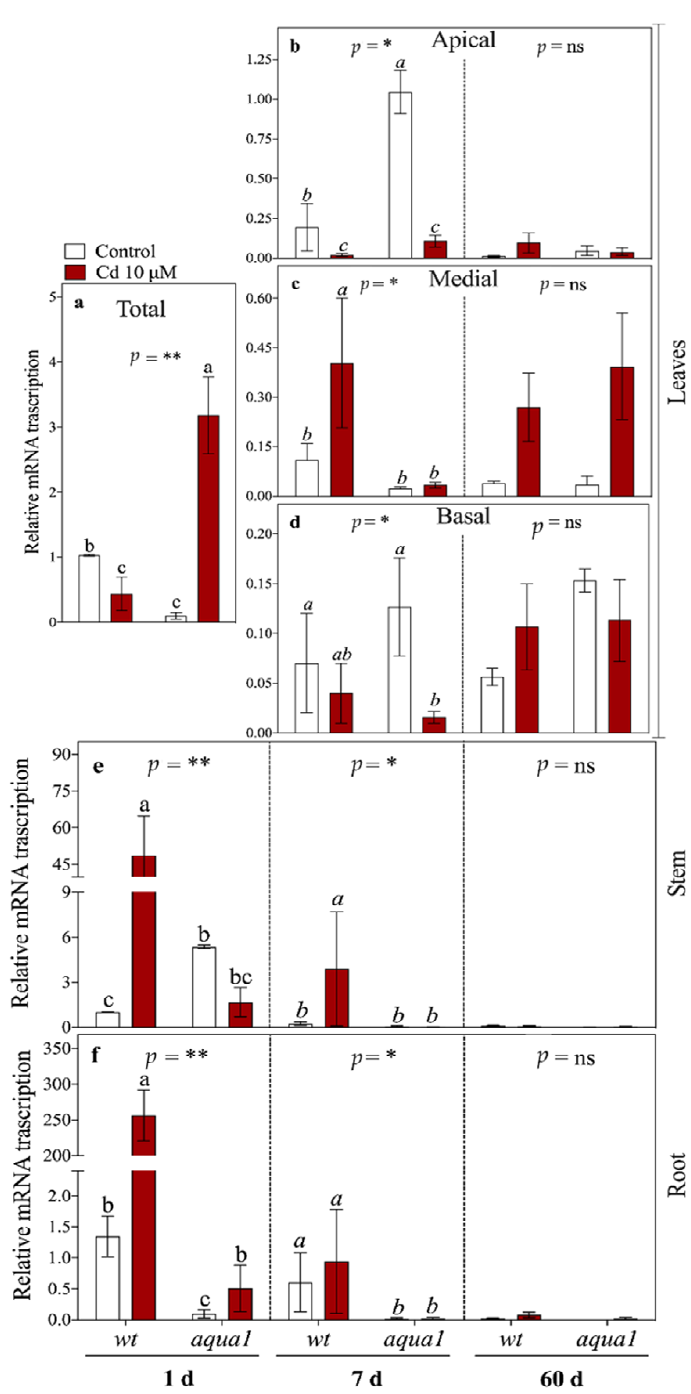
Figure 4. PaHMA2 gene relative transcript abundances in leaves ( a – d ), stem ( e ), and root ( f ). In the first sampling time (1 d) the leaves were not divided in three groups ( a ) while at 7 and 60 d leaves were divided in three groups: apical ( b ), medial ( c ), and basal ( d ). Values represent the mean of three biological replicates ± SE. Data were analyzed with two-way ANOVA; p -values correspond to the interaction between Cd and Line are reported in the figure (* = 0.01 < p < 0.05, ** = 0.001 < p < 0.01, ns = not significant). When the interaction was significant, different letters indicate significant differences among treatments at each sampling time and organ. Cd and Line p -values are reported in Supplementary Materials Table